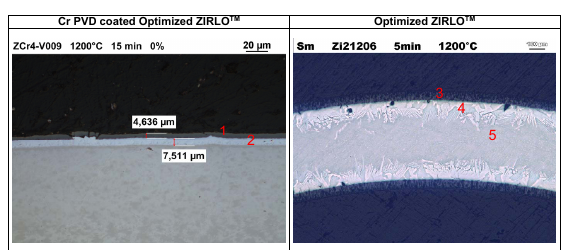
Figure 8. Microstructure after oxidation in steam for Cr PVD coated sample oxidized for 15 minutes in comparison with uncoated sample oxidized for 5 minutes. (1. Cr oxide 2. Cr metal layer 3. ZrO 2 4. α - Zr(O) 5. prior β